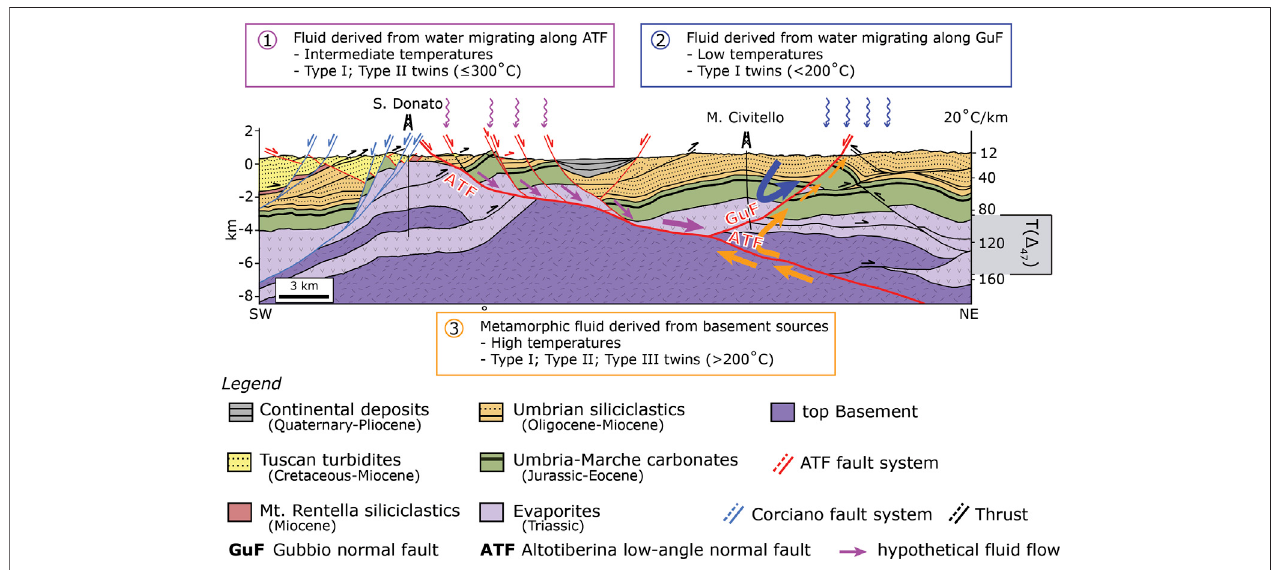
FIGURE5 | Hypotheticalscenariosfor fl uid source tothe GuF. Scenario 1(pink): meteoric fl uid enters the ATF breakaway zone, travels alongthe detachment, and emerges along the GuF. Scenario 2(blue): meteoric fl uid enters and recirculates along the GuFdamage zone fractures. Scenario3 (orange): hydrothermal metamorphic fl uids migrate up the ATF and emerge along the